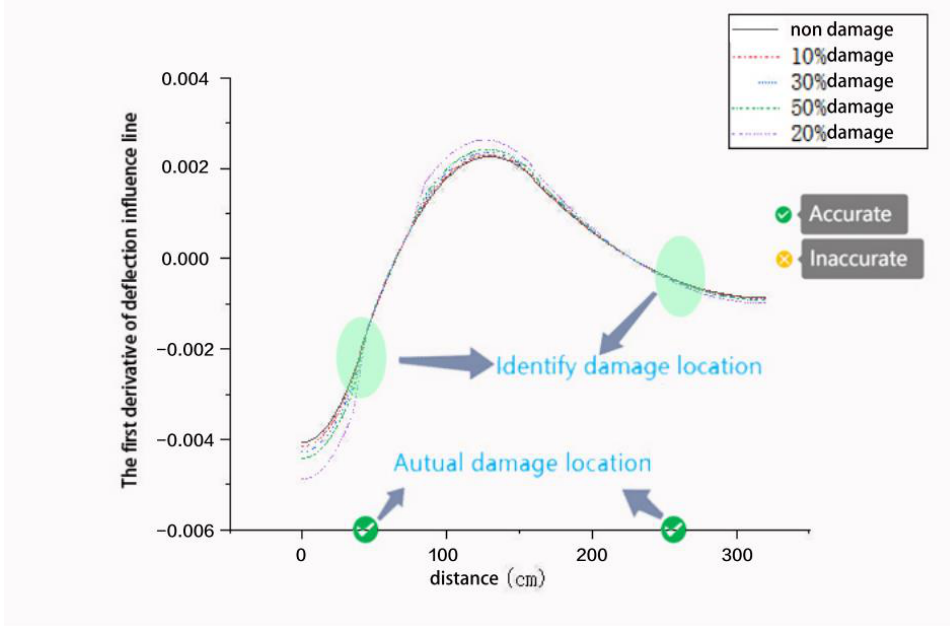
Under condition 1 (1-5) and condition 2 (1-5), the 1st derivative of deflection influence line obtained from 1/4 determining point of the first span is shown in Figures 11 and 12. It was found that the destruction site could not be recognized by image.